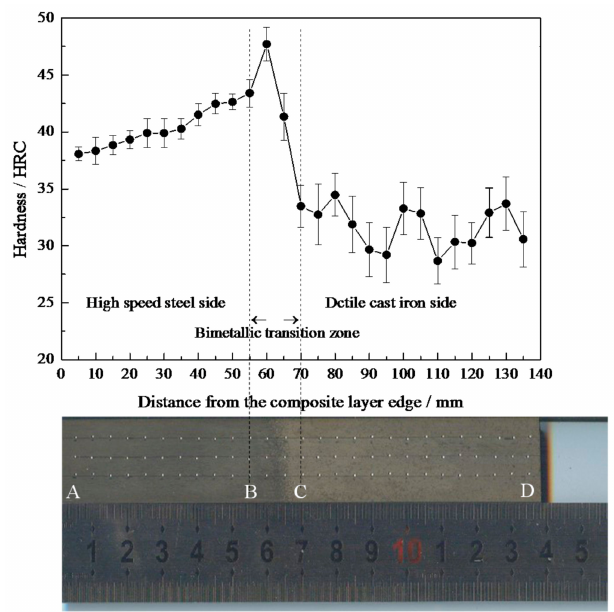
Figure 10. Hardness test of the bimetallic bonding interface in the radial